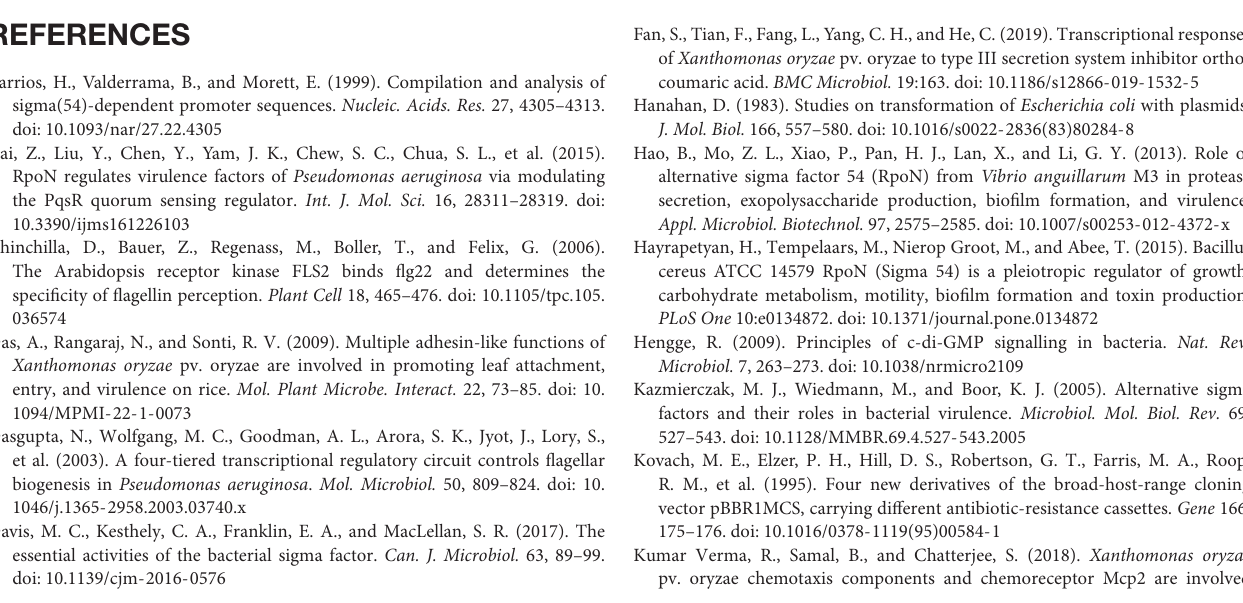
Supplementary Table 1 | Bacterial strains and plasmids used in this study. Supplementary Table 2 | Primers used in this